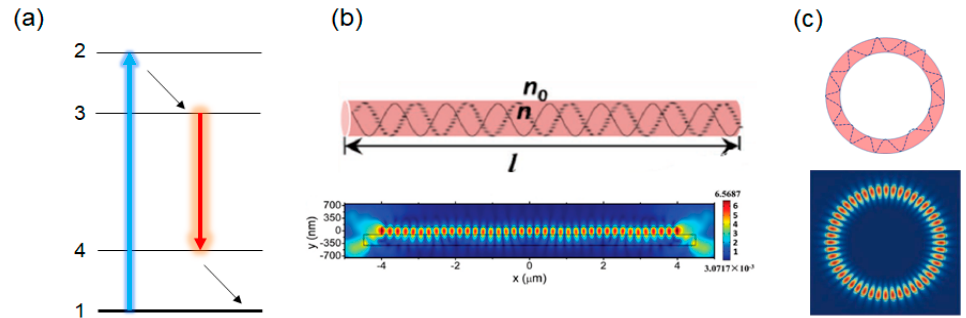
Figure 10. ( a ) Simplified 4-level laser system diagram involving photoexcitation (1 → 2), fast relaxation to the lowest excited state (2 → 3), spontaneous and stimulated emission (3 → 4), and ground state recovery (4 → 1). ( b ) Optical waveguiding in a FP wire resonator showing optical confinement due to reflection at the wires tips (up) and distribution of the internal electric field (down). Reproduced with permission from ref. [119]. Copyright 2017 Wiley-VCH. ( c ) Optical confinement on a WGM ring resonator (up) and internal distribution of the electric field (down). Reproduced with permission from ref. [128]. Copyright 2020 Wiley-VCH.